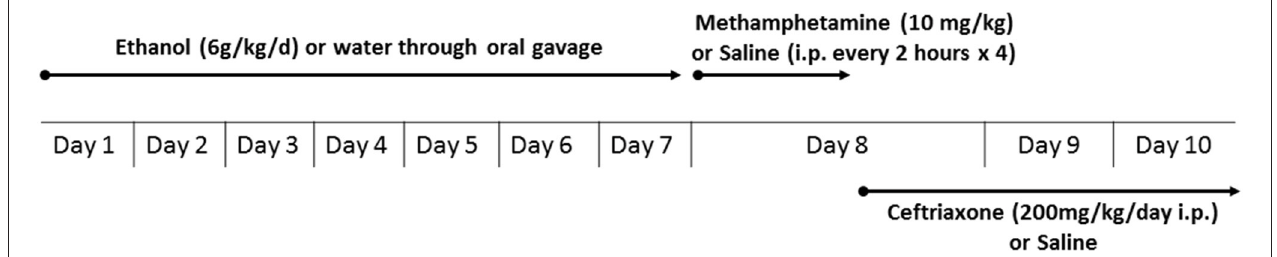
FIGURE 1 | Experimental schedule for METH and ethanol administration. Rats were administered oral gavage of either water or ethanol (6g/kg) for 7 days followed by either METH (10mg/kg i.p., every 2h for 4 times) or saline vehicle (i.p.). After completion of the four METH injections, rats were randomly assigned to receive either CEF (200 mg/kg i.p.) or saline vehicle (i.p.) for 2 days. Control and treated rats were then quickly euthanized (72 and 48h following last water/ethanol and saline/METH administration, respectively) by CO2 inhalation and rapidly